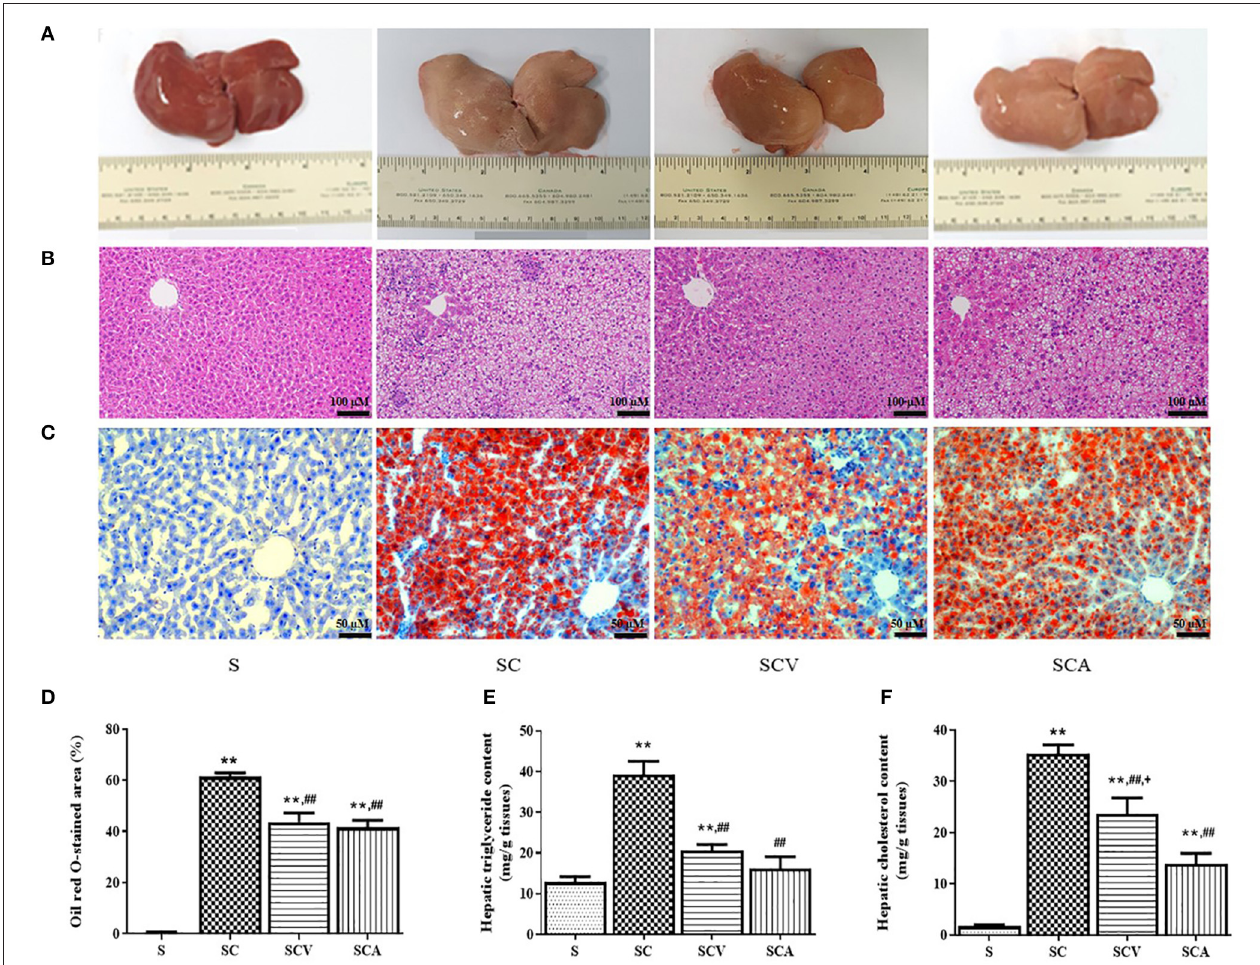
FIGURE 5 | Coconut vinegar supplementation reduced hepatic lipid accumulation. (A) Liver morphology; (B) Hepatic H&E staining; (C) Hepatic Oil red O staining; (D) Oil red O stained-area; (E) Hepatic triglyceride content; (F) Hepatic cholesterol content. Each bar presented in mean ± SEM. ** p < 0.01 vs. the control group; ## p < 0.01 vs. the SC group; + p < 0.05 vs. the SCA group ( n = 6 per group).